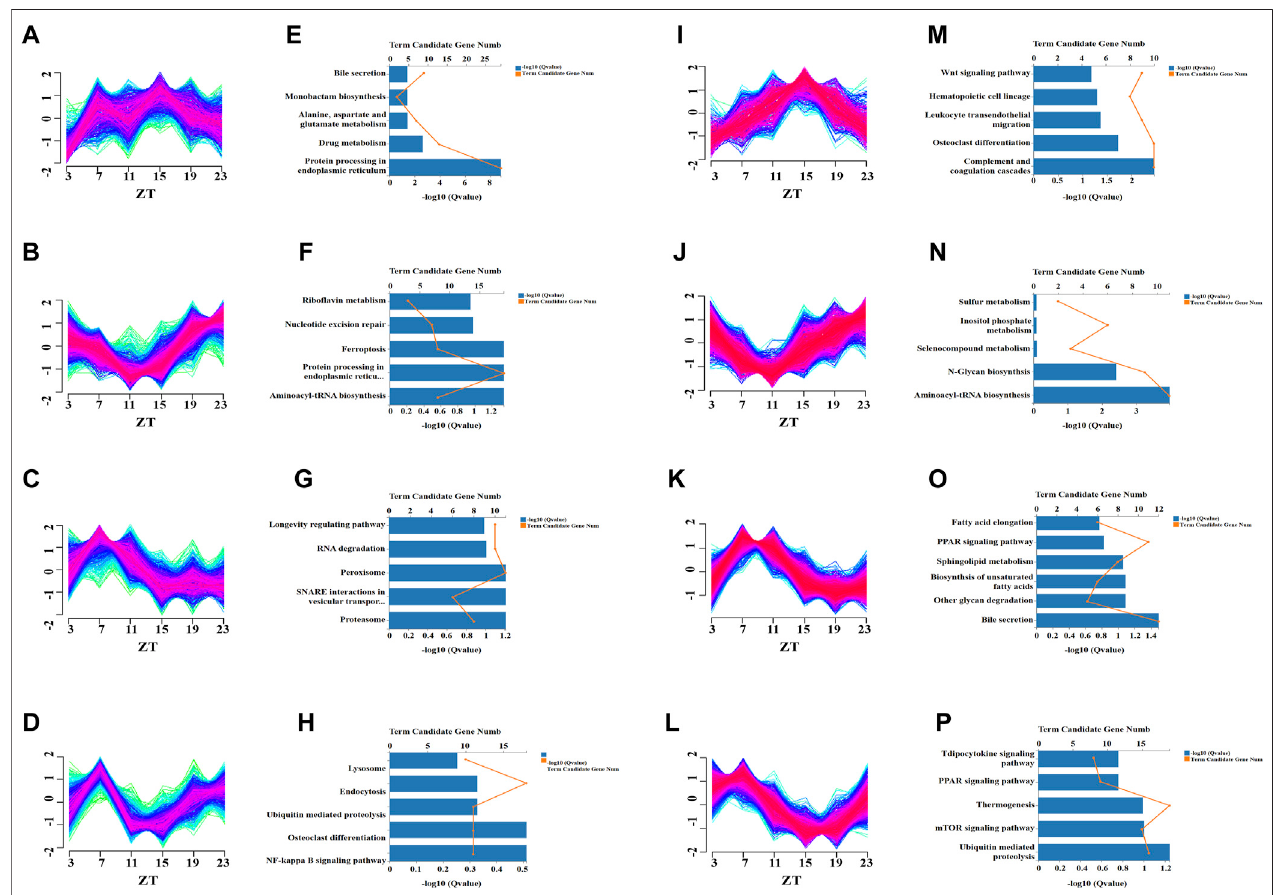
FIGURE 4| Temporal analysisrevealed that chronic cold-induced changesin speci fi c transcription patterns. Clustering analysis was performed on the genesof Ⅲ and Ⅳ liver groups (from Figure 3C ), and the control and chronic cold groups were separated into four different enrichment clusters. (A – D) Temporal gene Z-scores fromfourdifferentenrichedclusterstothecontrolgroupoftheliver.Theexpressionvalueswerestandardized.Theblueandgreenlinesrepresentlow-membership-value genes, while the red lines represent high-membership-value genes. (E – H) KEGG pathway enrichment analysis for the transcripts in clusters 1 – 4 unique to the control group of the liver ( p < 0.05). (I – L) Temporal gene Z-scores from four different enriched clusters of the liver ’ s chronic cold (CC) group. (M – P) KEGG pathway enrichment analysis for the transcripts in clusters 1 – 4 of the chronic cold (CC) group of the liver ( p < 0.05).